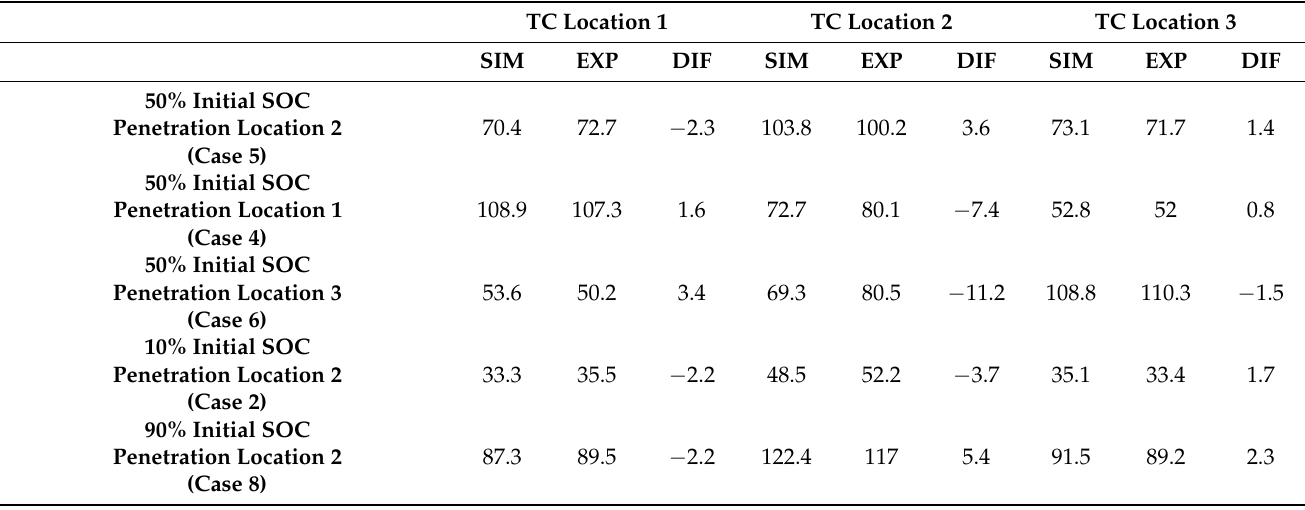
Table 4. Comparison between simulated and experimental temperature data at Thermocouple (TC) Locations 1, 2, and 3 and at selected time points in Cases 2, 4, 5, 6, and